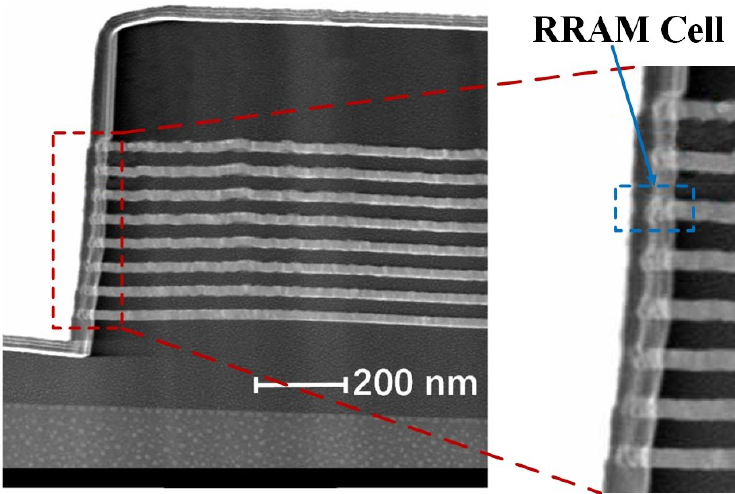
Figure 2. TEM image of the HfO 2 /TaO x -based built-in nonlinear 3-D VRRAM structure.